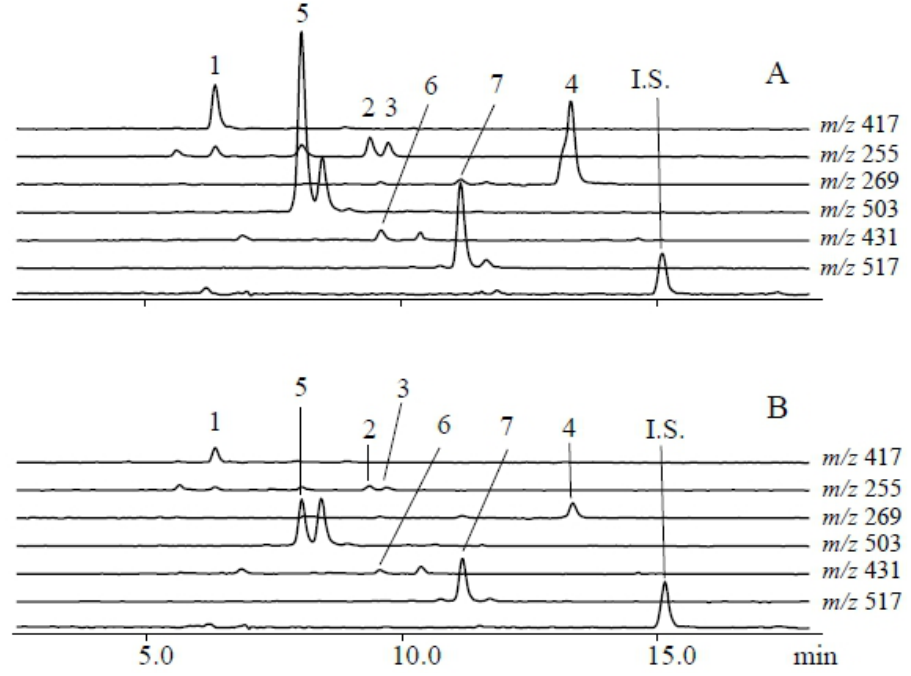
Figure 6. Elicitation of soybean leaves with S. litura gut contents results in a more complex induced flavonoid profile. Representative LCMS [M+H] + selected ion chromatograms of soybean leaves 48 hours after treatment with either ( A ) S. litura gut contents or ( B ) buffer only controls. Flavonoid analytes are as follows: (1) daidzin ([M+H] + , m/z 417); (2) 4’,7-dihydroxyflavone ([M+H] + , m/z 255); (3) daidzein ([M+H] + , m/z 255); (4) formononetin ([M+H] + , m/z 269); (5) malonyldaidzin ([M+H] + , m/z 503); (6) ononin ([M+H] + , m/z 431); and (7) malonylononin ([M+H] + , m/z